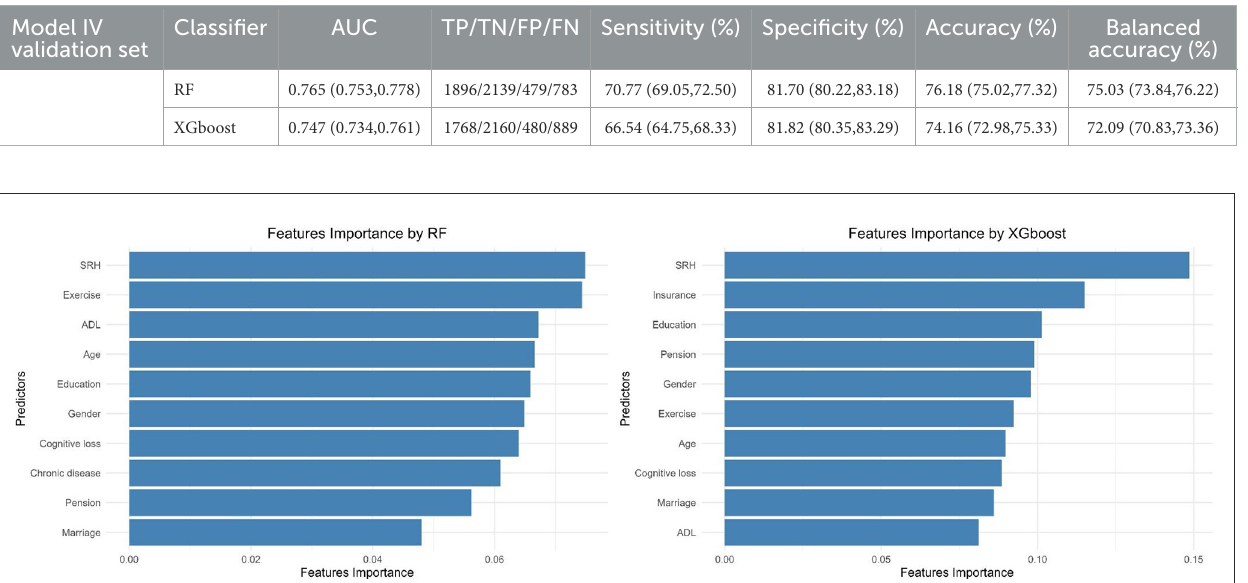
FIGURE2 The most important features of the older adults, who demanded for medical services provided by HCBS in CLHLS